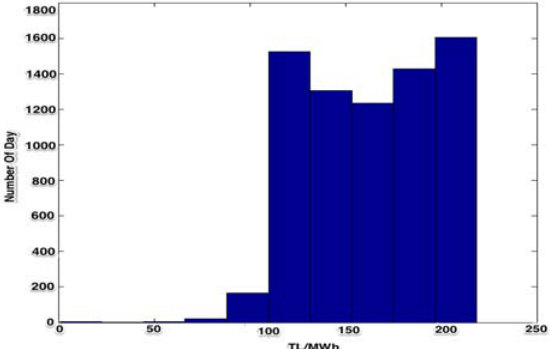
Fig. 11. Histogram of day-ahead electricity